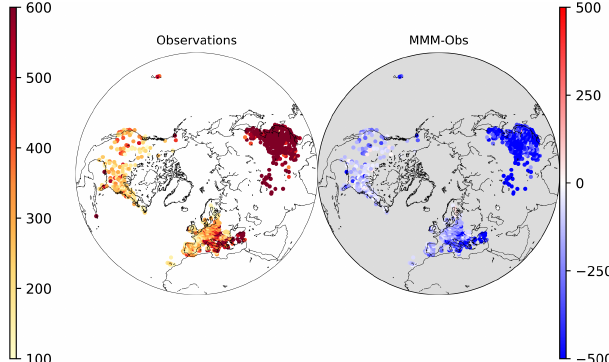
and/or mixing of tropospheric O 3 in most of the models.